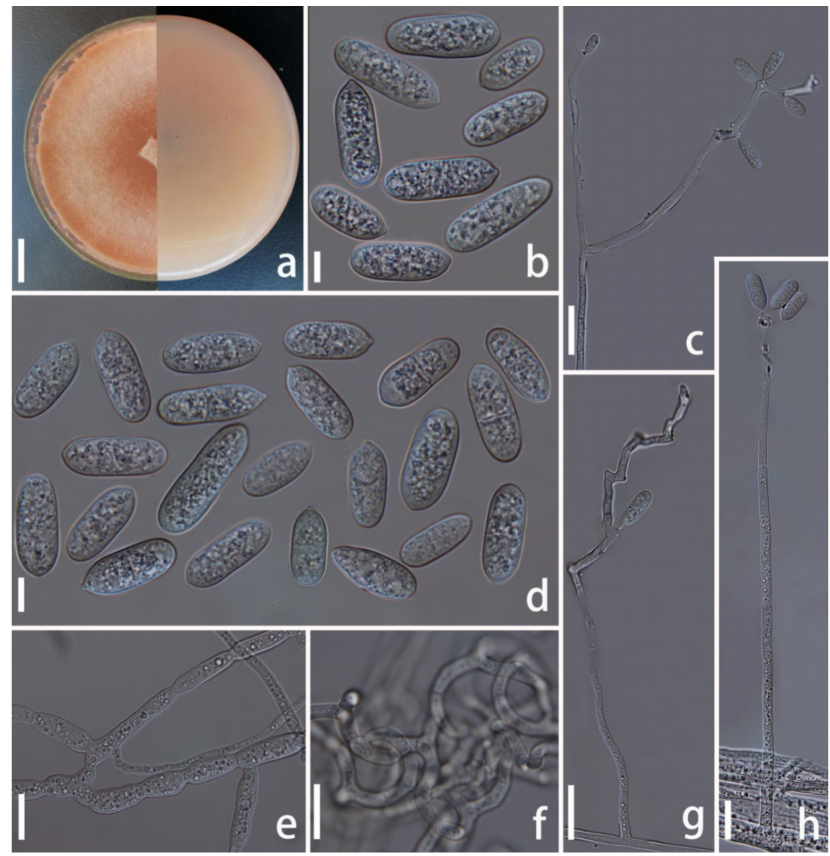
Figure 6. Arthrobotrys shuifuensis (CGMCC3.19716). ( a ) Colony. ( b , d ) Conidia. ( e ) Chlamydospores. ( c , g , h ) Conidiophores. ( f ) Trapping device: adhesive networks. Scale bars: ( a ) = 1 cm, ( b , d , e ) = 10 µ m, ( c , f – h ) = 20 µ